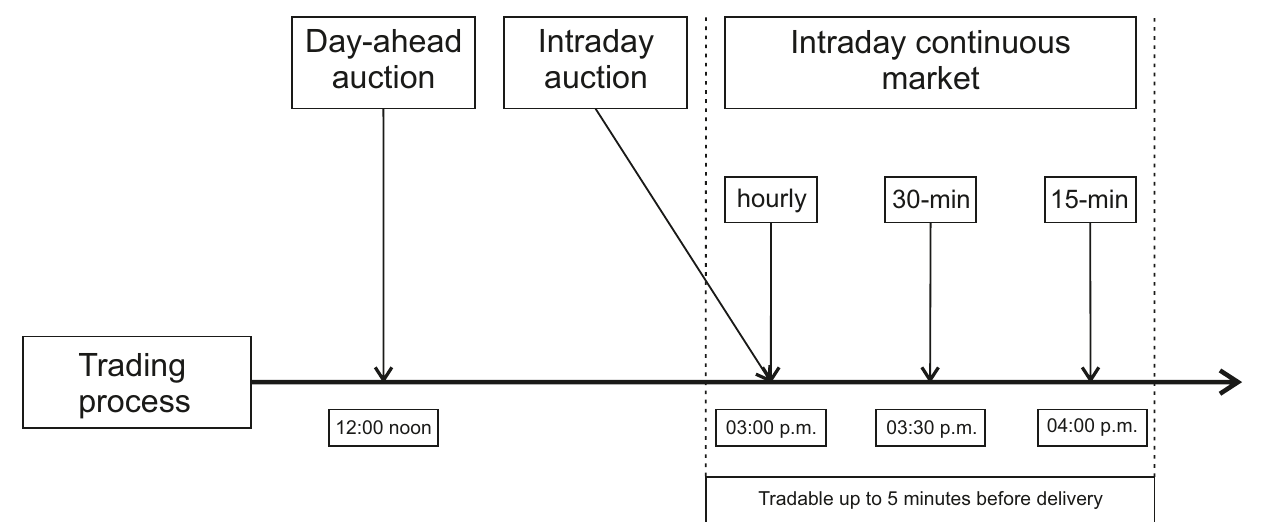
Figure 1. Typical structure of a trading day on EPEX SPOT. The day-ahead auction is at 12 p.m. (noon). Trading for hourly contracts on the continuous intraday market starts at 3 p.m. and is possible until 5 min before delivery. Until June 2017, trading on the continuous intraday market was possible only up to 30 min before delivery. Afterwards, trading was possible within a control zone until 5 min before